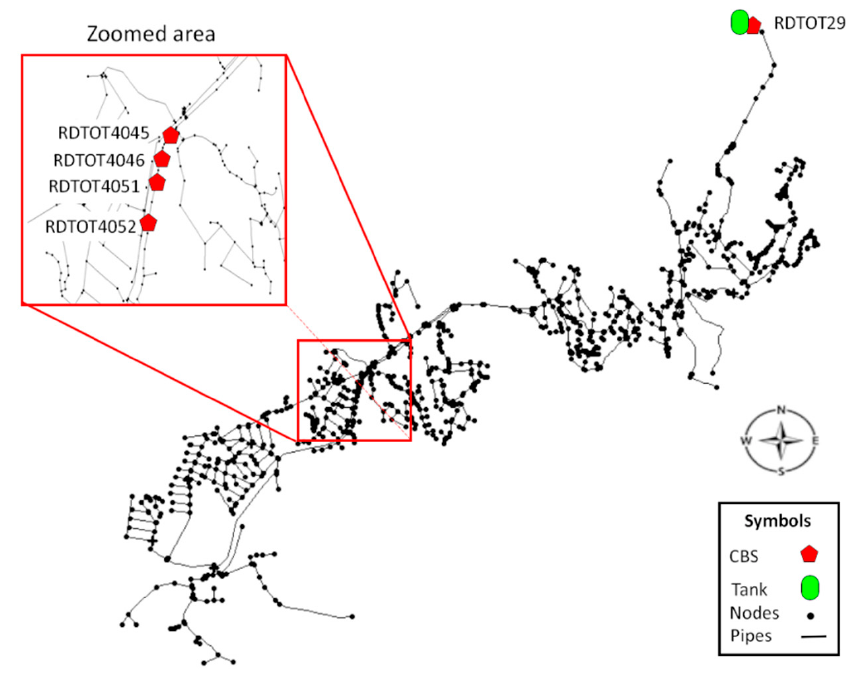
Figure 12. CBS location proposed by the PSO simulation in Case 2.